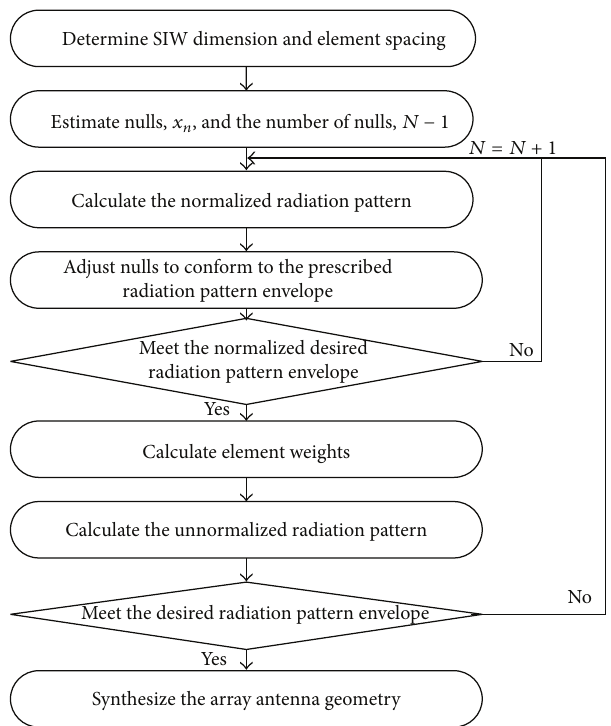
Figure 1: Design flow diagram for an SIW slot array antenna with a desired radiation pattern